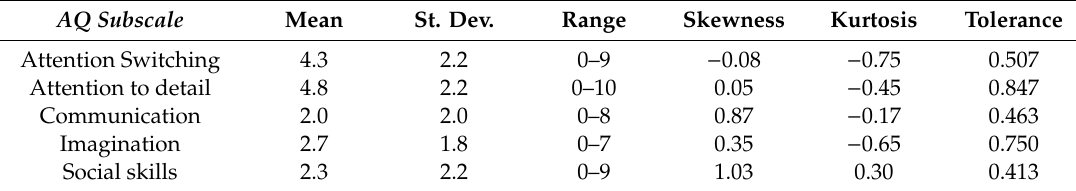
Table 1. Distribution and collinearity indexes of the AQ subscale